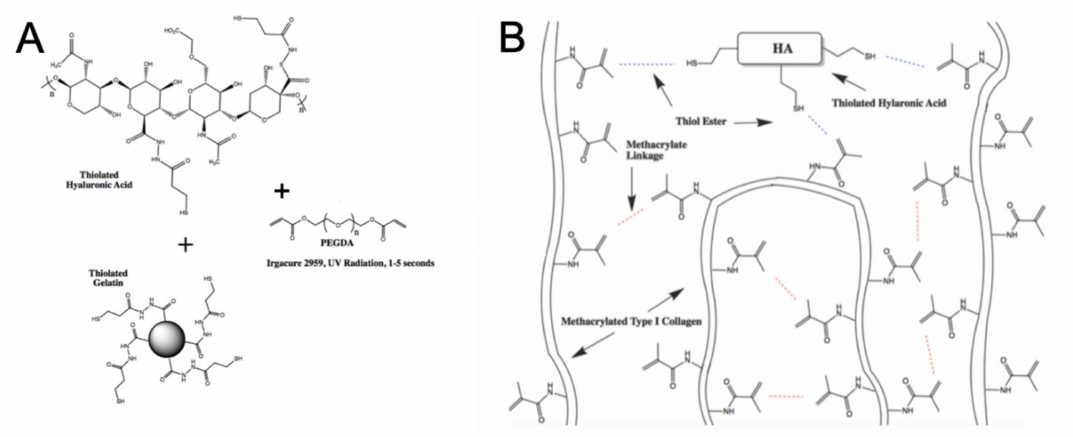
Figure 1. Hydrogel compositions. ( A ) The HyStem hydrogel system, comprised of thiolated hyaluronic acid, thiolated gelatin, and a polyethylene glycol diacrylate (PEGDA) crosslinker. ( B ) Our collagen–hyaluronic acid (HA) hydrogel formulation, comprised of methacrylated collagen and thiolated hyaluronic acid.